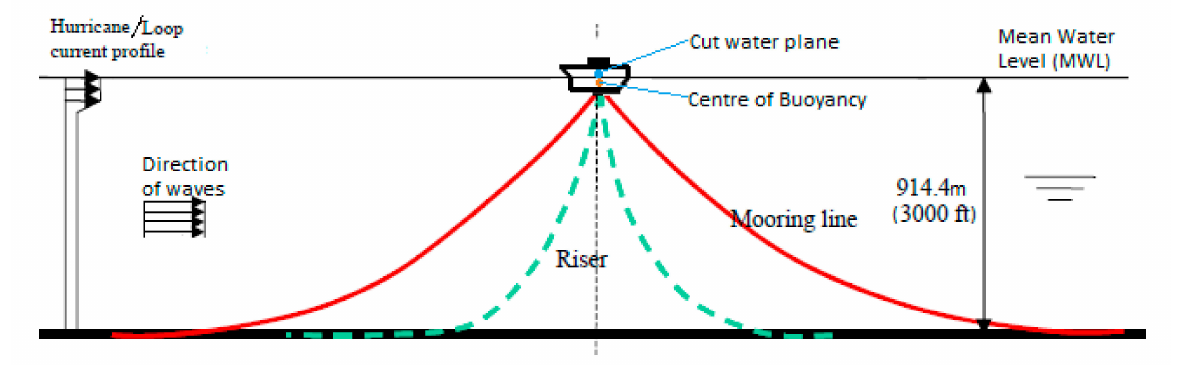
Figure 16. Schematic showing risers and mooring lines on a floating